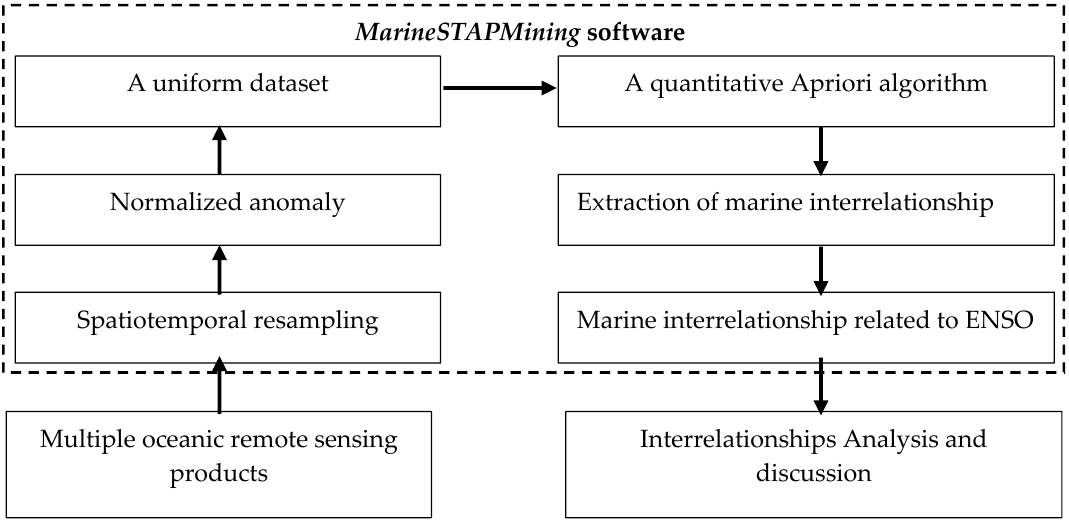
Figure 1. A flowchart of this manuscript.